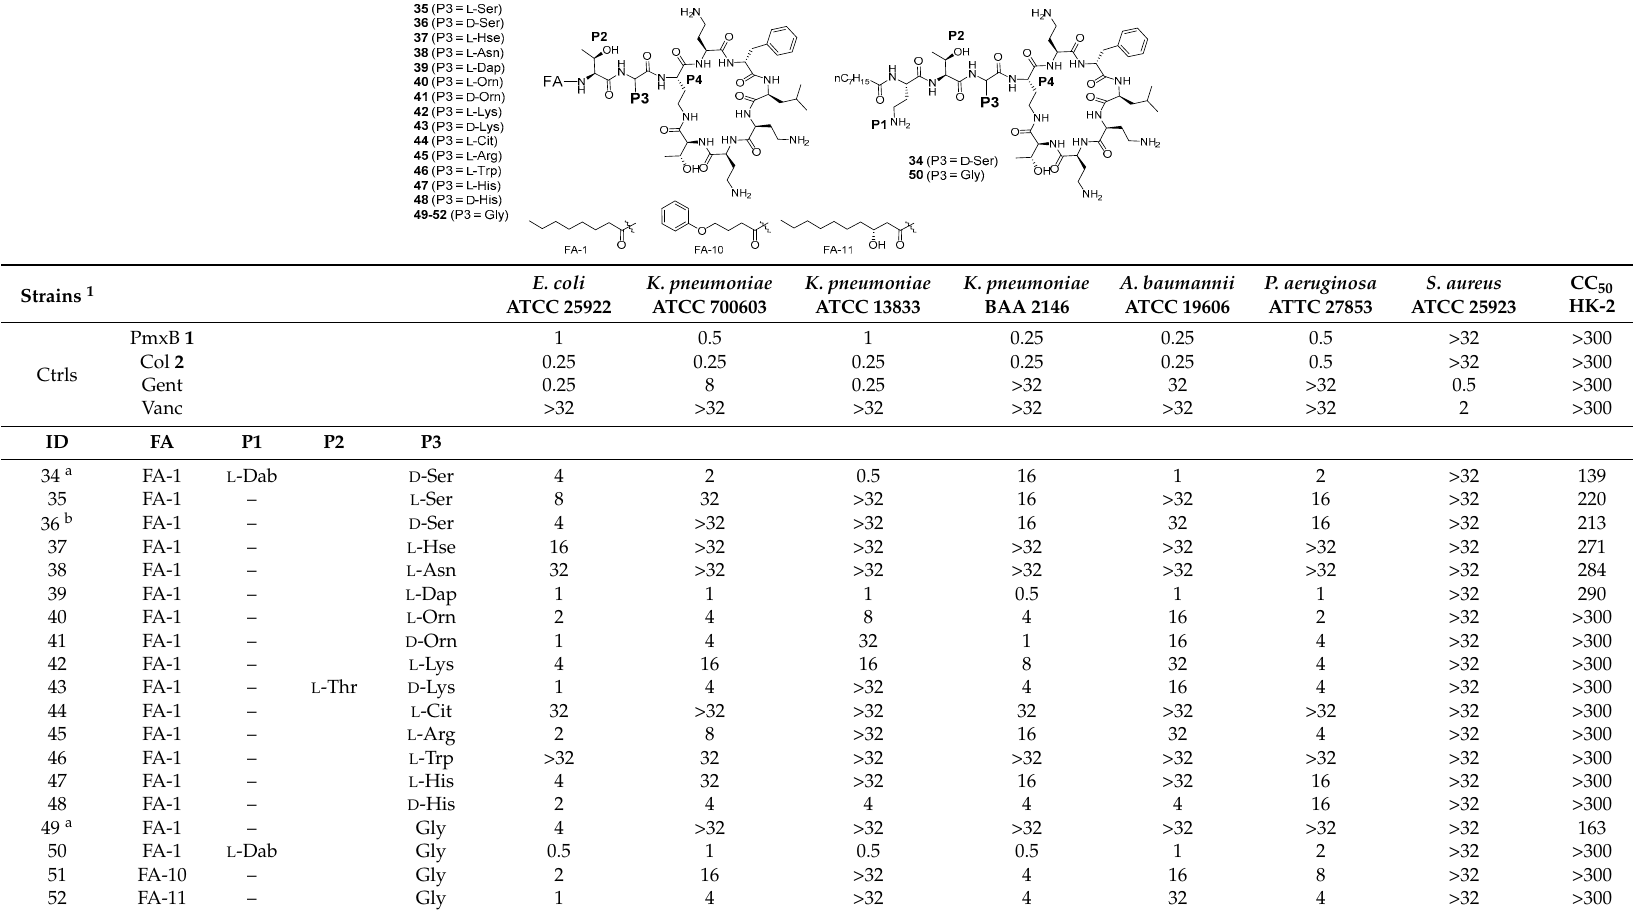
Table 3. Summary of antimicrobial activity (MIC, mg/L) and cytotoxicity (CC 50 , µM) against HK-2 cells for a series of polymyxin-B nonapeptide (PMBN) derivatives acylated with different fatty acids and varying the P3 residue.